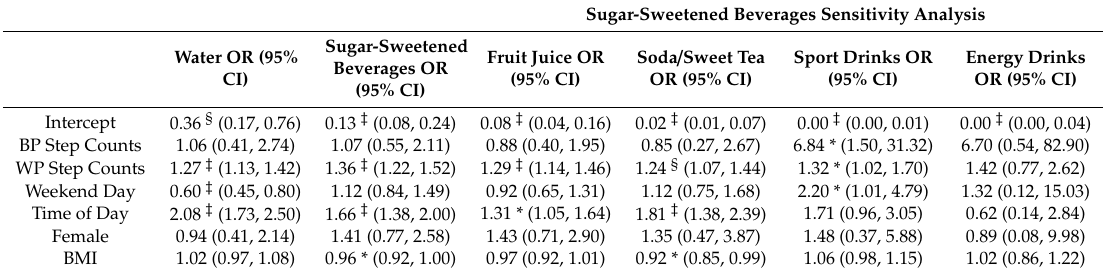
Table 3. Results from multilevel models predicting the odds of fluid